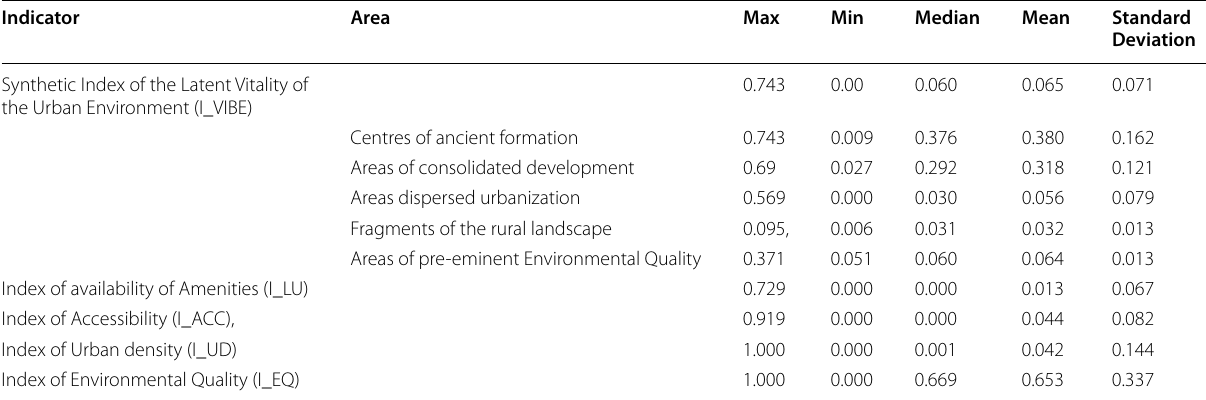
Table 3 Values of the dimensional indicators and of the synthetic index of the latent vitality of the urban environment and related measures of central tendency and dispersion Indicator Area Synthetic Index of the Latent Vitality of the Urban Environment